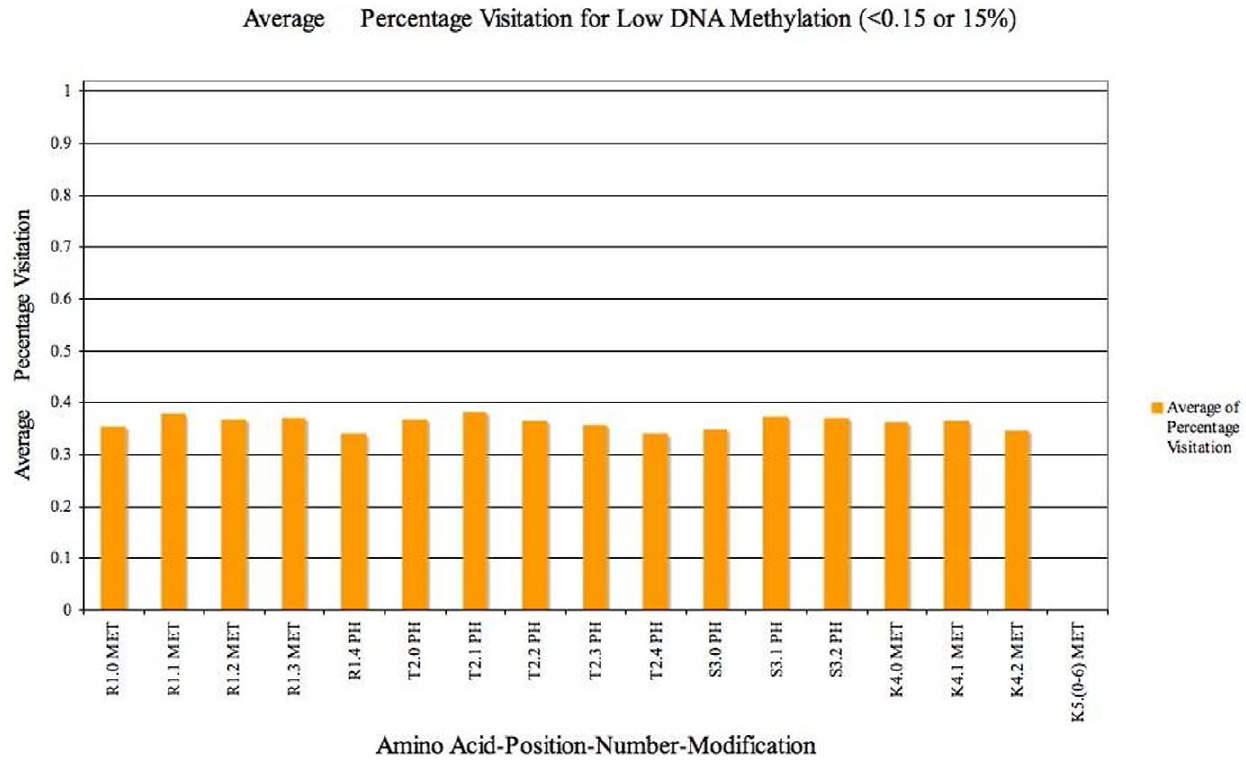
Figure 6. Analysis of Average percentage visits of H3 histone states containing LysineAcetylation.i.eK6 in 16 promoters after 5000 iterations (for low levels of DNA Methylation ( , 0.15 or 15%)). States containing Lysine acetylation are visited the most. Hence we analyse the the average of percentage visitation of model to all other modifications (except Lysine Acetylation - K6 in Figure) during the simulation. Here each unit in the X-axis represents an amino acid–position in H3 array–number of Amino acids–Modification possible. The Y axis elaborates on the average percentage visitation of H3 states that contain the modification depicted in each unit of X axis.